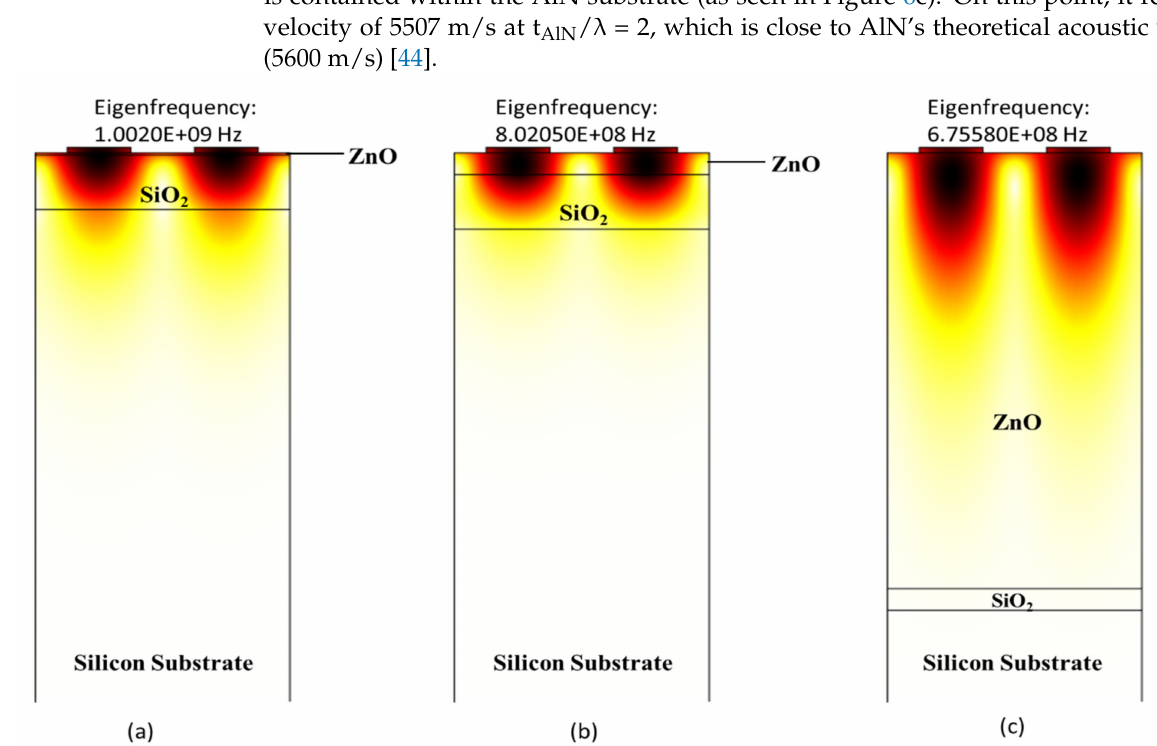
Figure 4. Zoom-in view of wave confinement and displacement profiles of structure A (ZnO/SiO 2 /Si) in Rayleigh mode with the normalised thickness of ZnO ( a ) 0.01, ( b ) 0.1 and ( c ) 2.